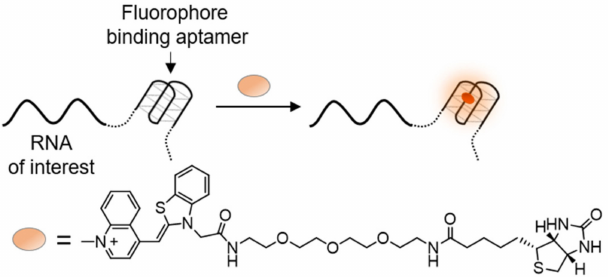
Figure 12. Labeling of target RNA molecules with TO-binding RNA Mango. Shown are the operating principle of RNA Mangos along with the chemical structure of